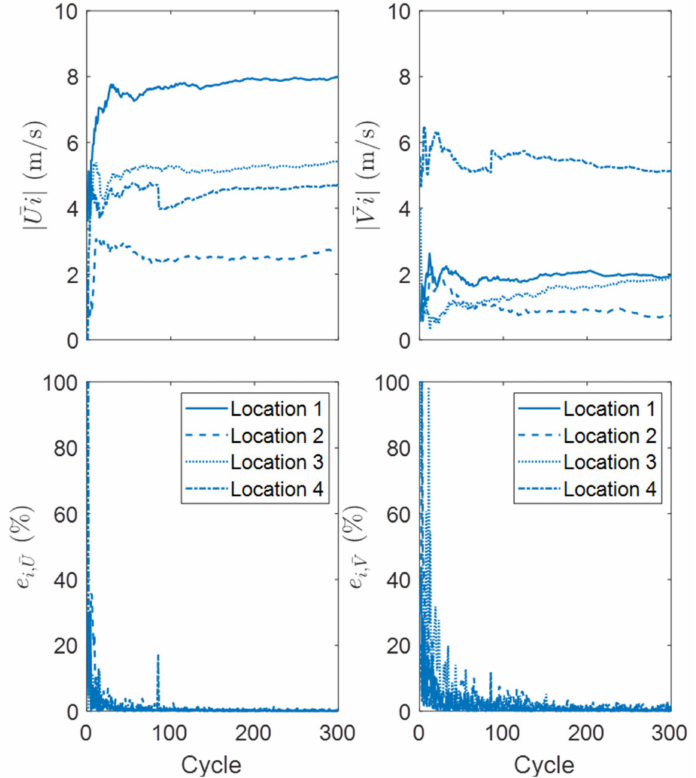
Figure 5. Convergence of the mean velocity